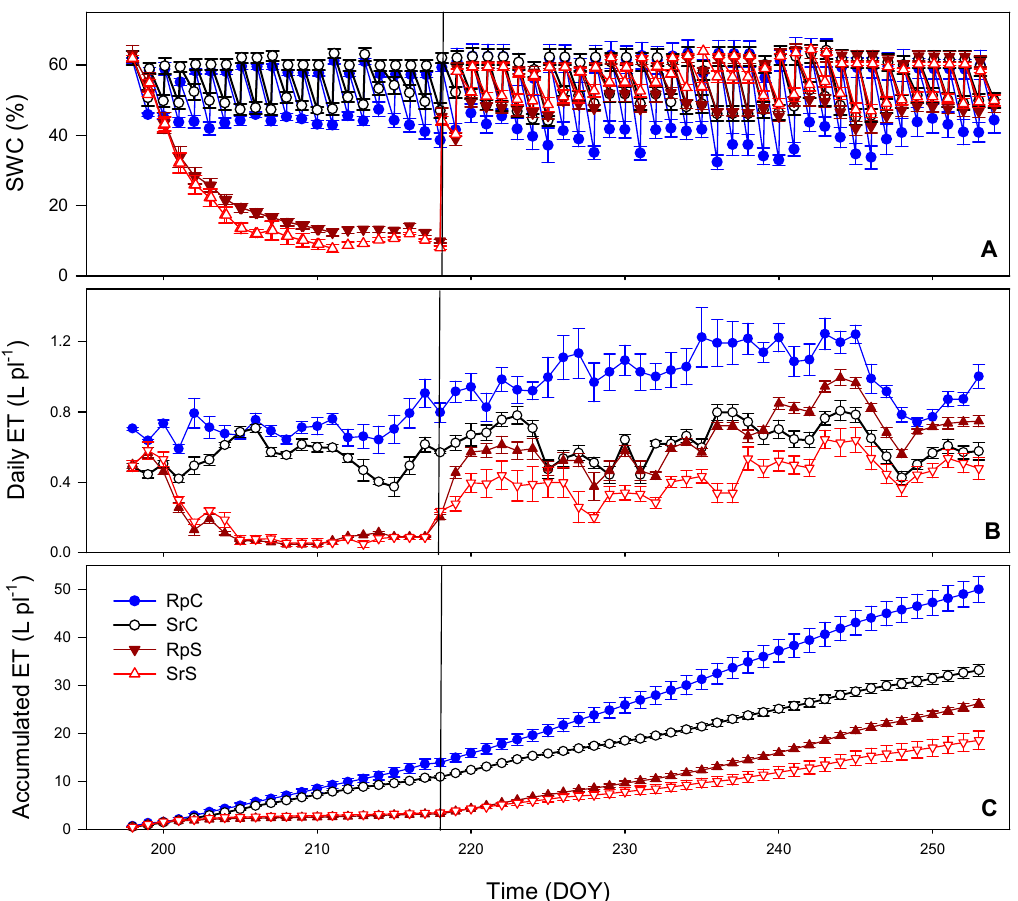
Figure 1. Evolution of the substrate volumetric water content (SWC, ( A )), daily evapotranspiration (ET, ( B )) and accumulated evapotranspiration ( C ) in P. dulcis plants submitted to different treatments. Values are means + s.e., n = 5. Symbols represent the different treatments: RpC (filled circles; plants grafted under full irrigation), SrC (open circles; self-rooted plants under full irrigation), RpS (filled triangles; plants grafted submitted to water stress) and SrS (open triangles; self-rooted plants submitted to water stress). Vertical line indicates irrigation change, the end of the water stress period and the beginning of recovery period.